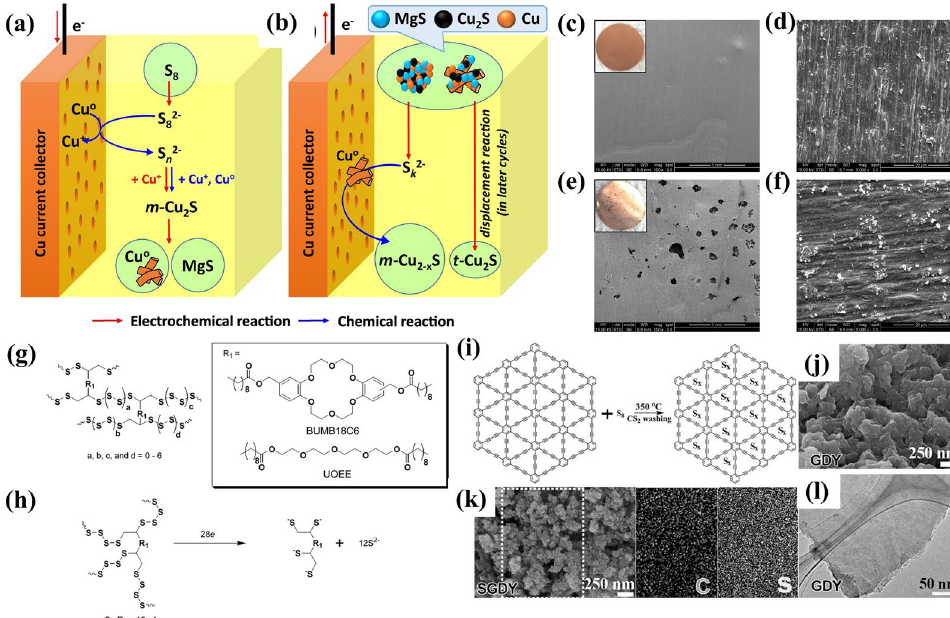
Figure 10. The proposed reaction mechanism diagram during ( a ) discharge and ( b ) charge. SEM of the Cu collector in Mg −S batteries: ( c , d ) original electrode, and ( e , f ) fully charged electrode after the first cycle [63] . ( g ) Structures of BUMB18C6 and UOEE. ( h ) Electrochemical reaction principles of sulfur − containing composites [76] . ( i ) The preparation process of SGDY, and corresponding ( j ) SEM image, ( k ) SEM images and corresponding element mapping, ( l ) HRTEM image [77] .